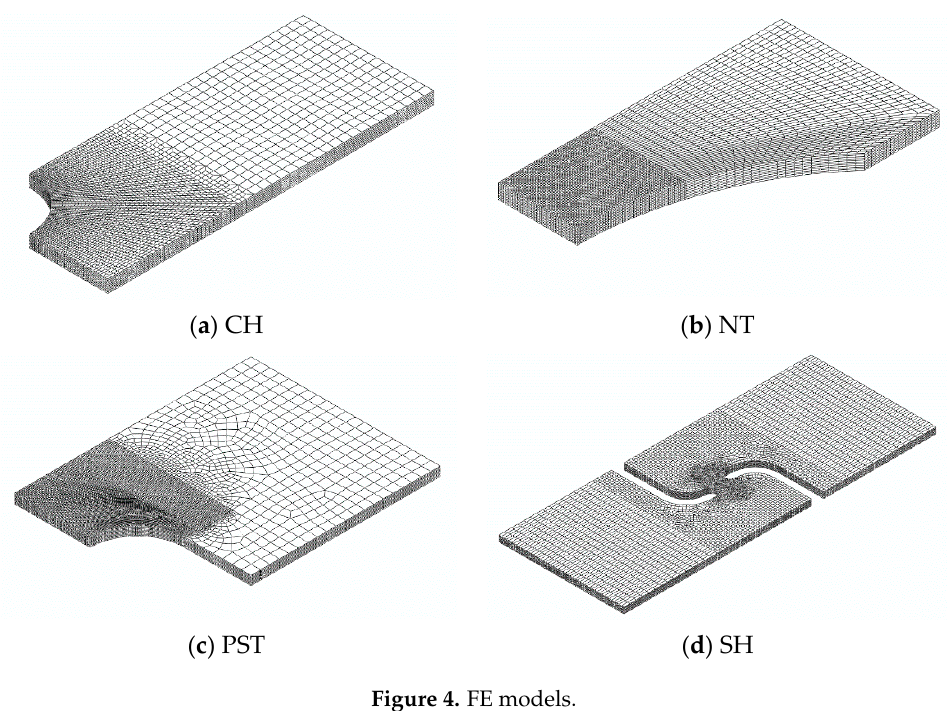
Figure 4. FE models.